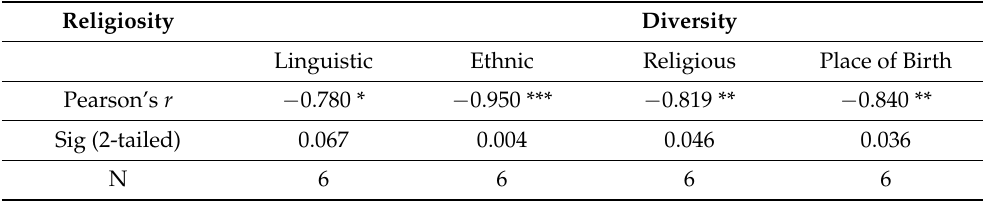
Table 2. Correlation between the religiosity index and diversity